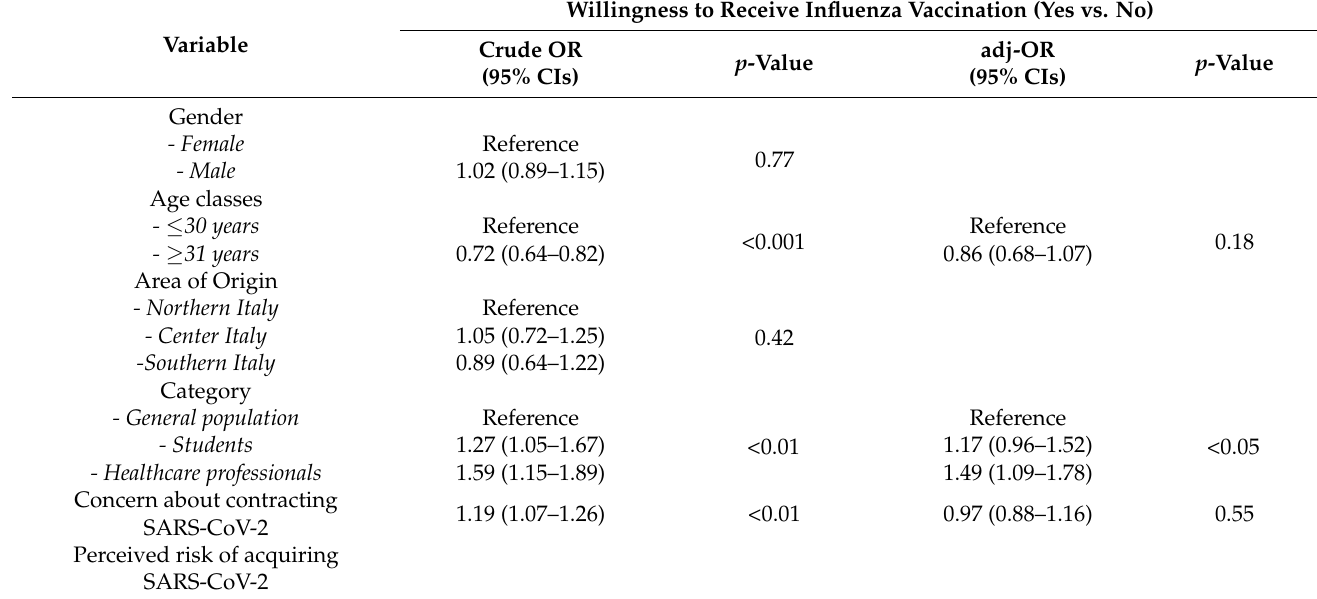
Table 4. Factors associated with influenza vaccination adherence in the univariable (crude OR) and multivariable (adj-OR) analyses. (adj-OR: adjusted odds ratio; 95% CI: confidence intervals